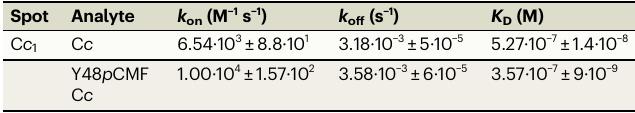
Table 1 | Analysis of surface plasmon resonance (SPR) curves Spot